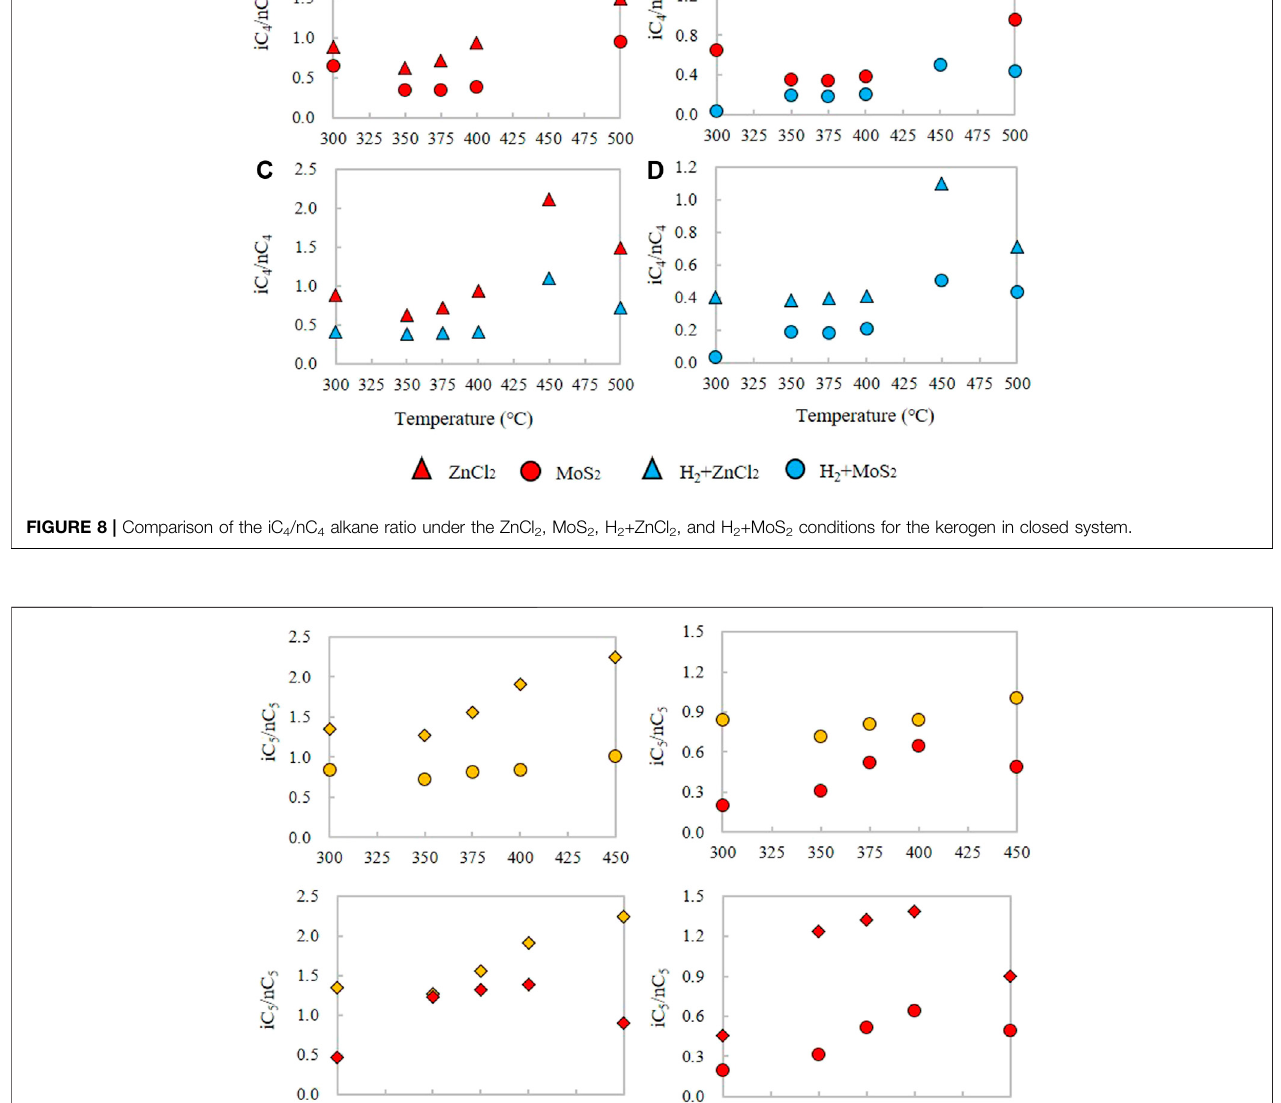
Frontiers in Earth Science |